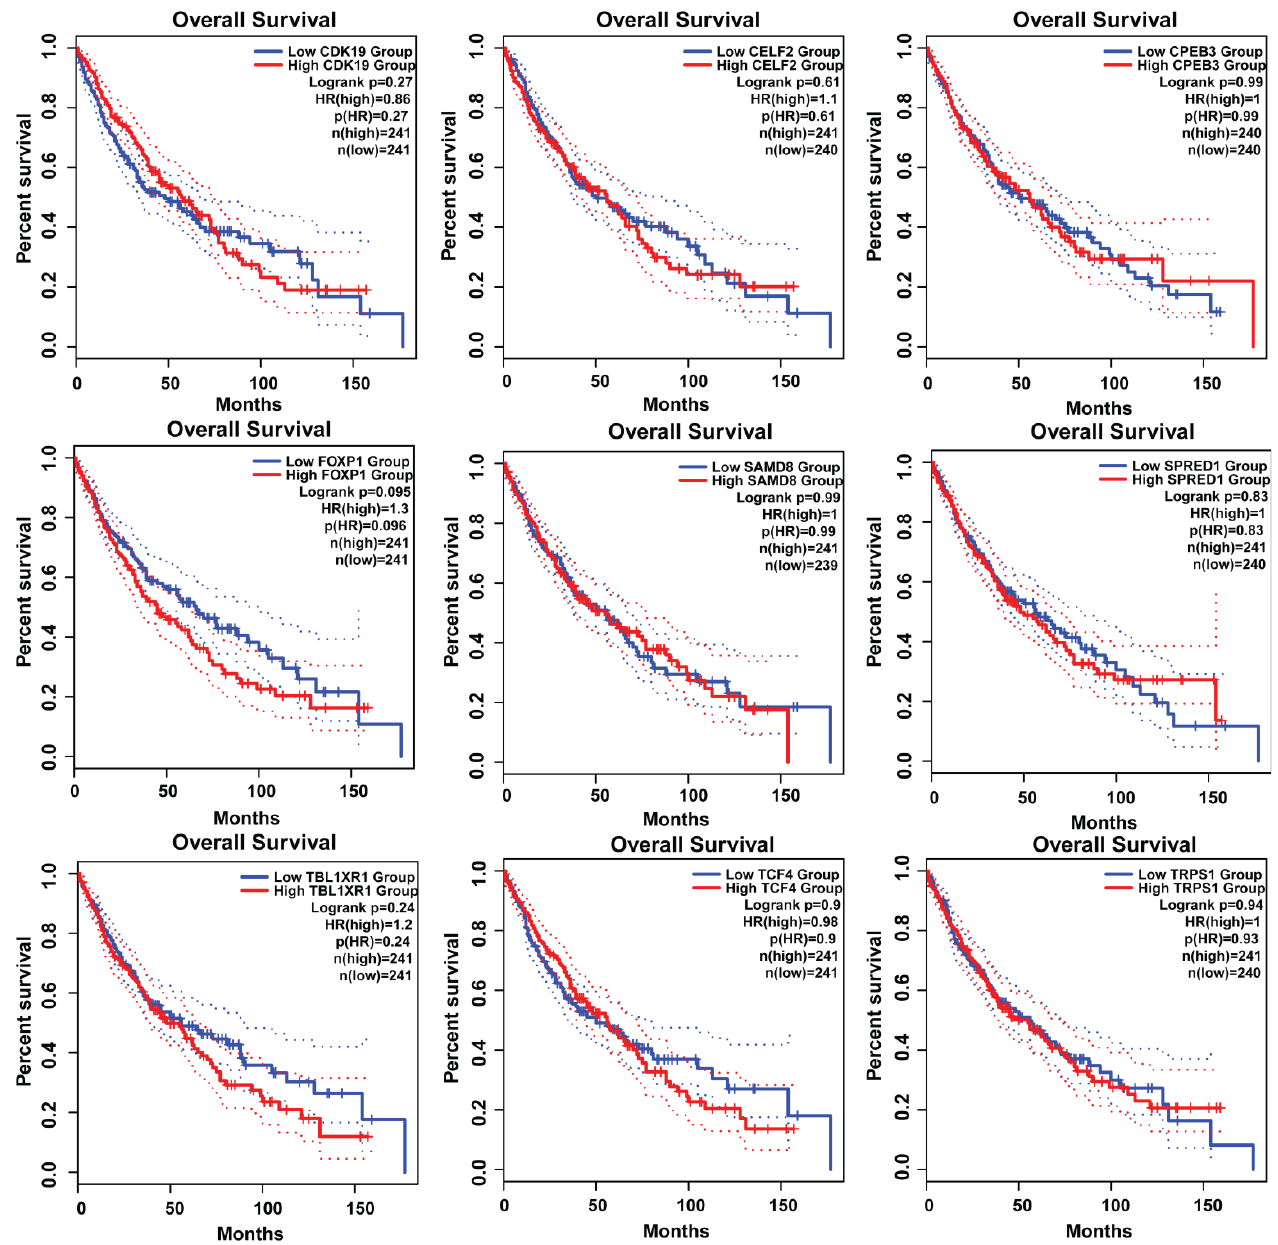
Figure 10. Survival analysis of key genes CPEB3 , SAMD8 , FOXP1 , TRPS1 , TCF4 , TBL1XR1 , SPRED1 , CELF2, and CDK19 . The survival curves of key genes in patients with NSCLC were obtained from GEPIA. Survival plots were used to show the survival ability with time and survival rate.